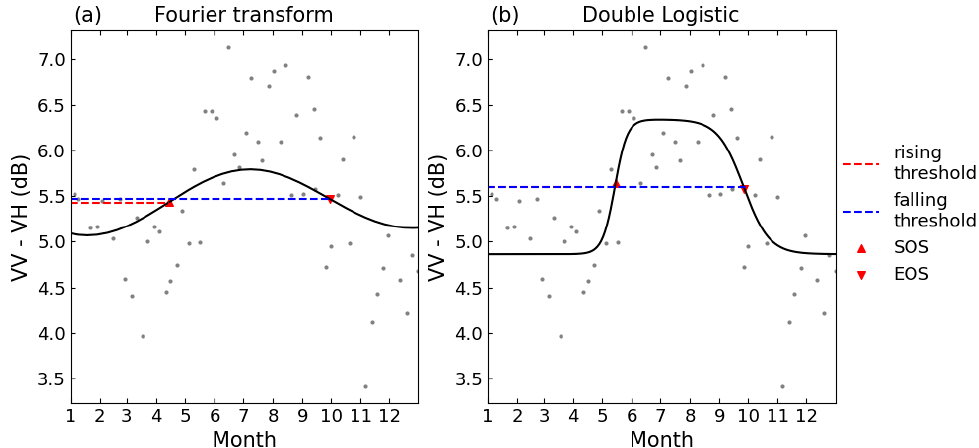
Figure 2. Schematics of curve fitting for ( a ). FT and ( b ). DL. Threshold for the phenological metrics was set as 50% of either the rising or falling period. The time series shown is for the 2018 growing season at site D02.SCBI.